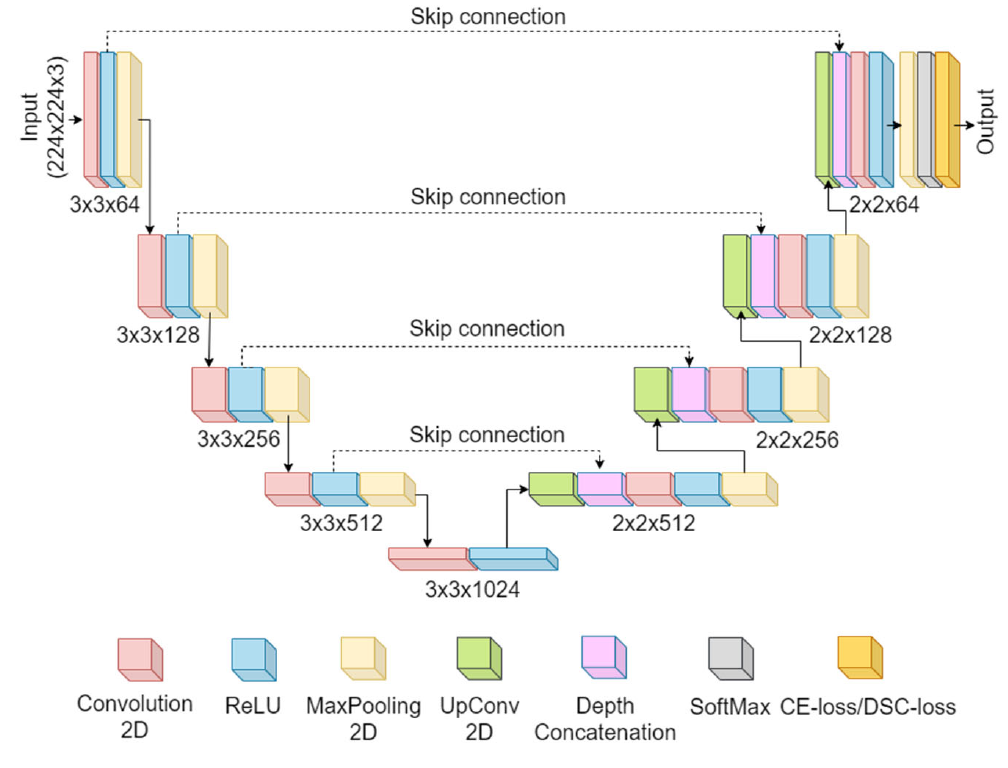
Figure 3. UNet architecture.